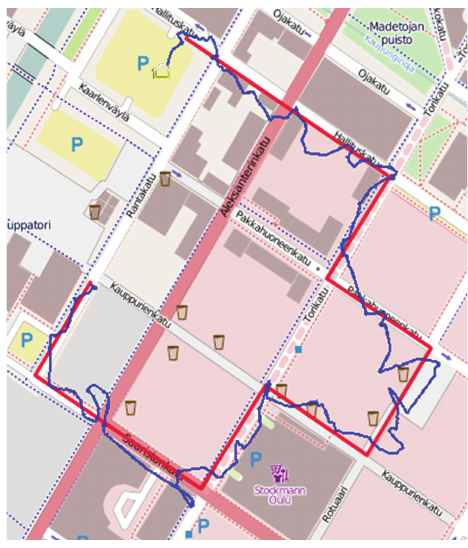
Figure 1: Route actually walked (red) and corresponding GPS locations logged